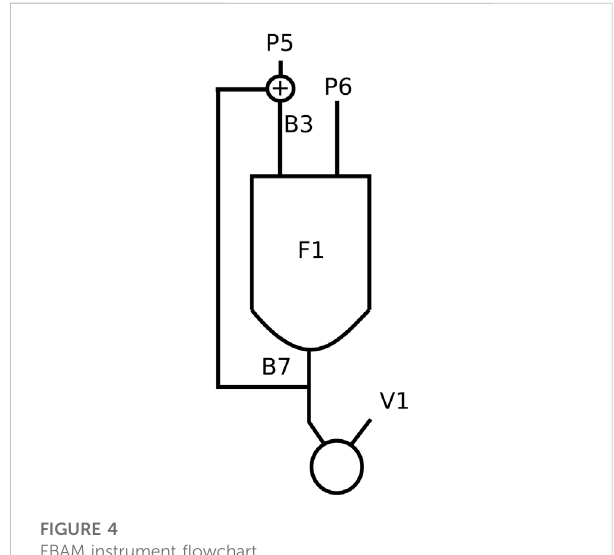
FIGURE 4 FBAM instrument fl